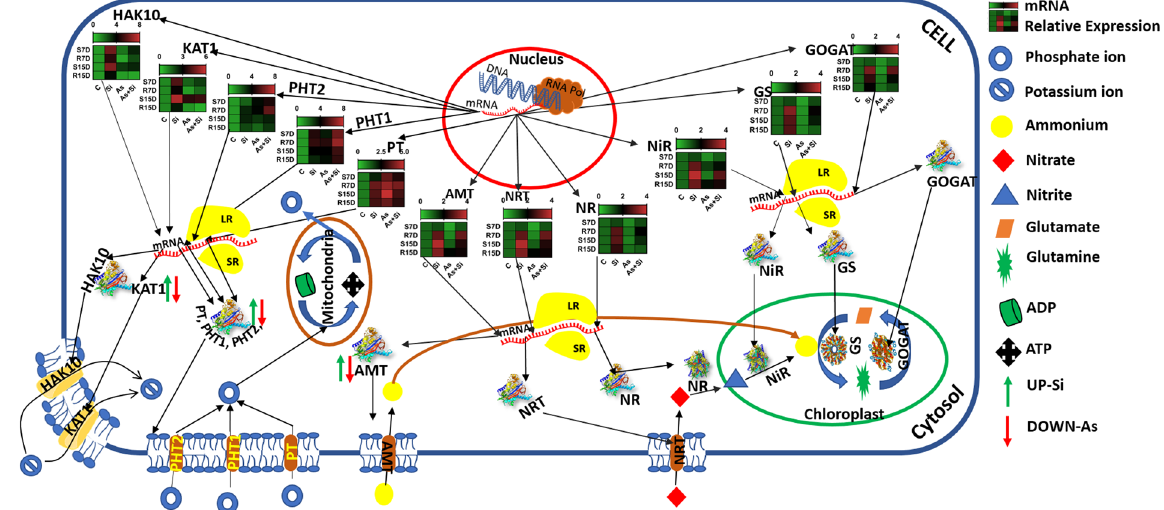
Figure 10. A schematic presentation of key genes involved in nitrogen, phosphorus and potassium (NPK) transport and their utilization system in a plant cell. Heat map represents the relative mRNA expression under different treatments.NO 3- are transported through NRT and NH 4 + through AMT in the cytosol. NO 3 − is reduced to NO 2 − by enzyme NR in the cytosol while NO 2 − is transported into the chloroplast and reduced to ammonium ion (NH 4 + ) by enzyme NiR . The NH 4 + ion takes part in glutamine synthesis and glutamine converts into glutamate by enzymes GS and GOGAT in the chloroplast. The inorganic phosphate (P i ) uptake was carried out by PT , PHT1 and PHT2 that leads to reversible synthesis of ATP and ADP in mitochondria. Potassium ions are taken up by KAT1 and HAK10 . The arrows, UP (green) and DOWN (red) in the figure is showing the expected possible mechanism where silicon (Si) and arsenic (As) might be responsible for up and/or down expression and modification of proteins that affects the function(s) of enzymes and transporters. (NO 3 − Nitrate; NRT-High Affinity Nitrate Transporter; AMT-High Affinity Ammonium Transporter; NR-Nitrate Reductase; NiR-Nitrite Reductase; GS-Glutamine Synthetase; GOGAT-Glutamate Synthetase; PT-Phosphate Transporter; PHT1 and PHT2- High Affinity Phosphate Transporter 1 and 2; KAT1-Potassium Transport Protein; HAK10- Potassium Channel